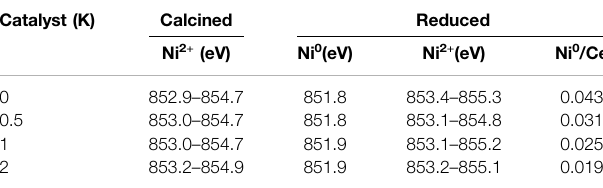
TABLE3| BindingenergiesoftheNi2p 3/2 levelsforthenon-reducedandreduced catalysts and Ni/support atomic